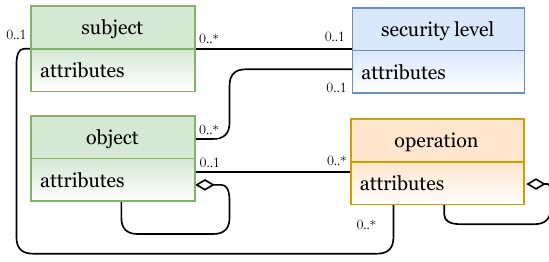
Figure 8. MAC model instance.